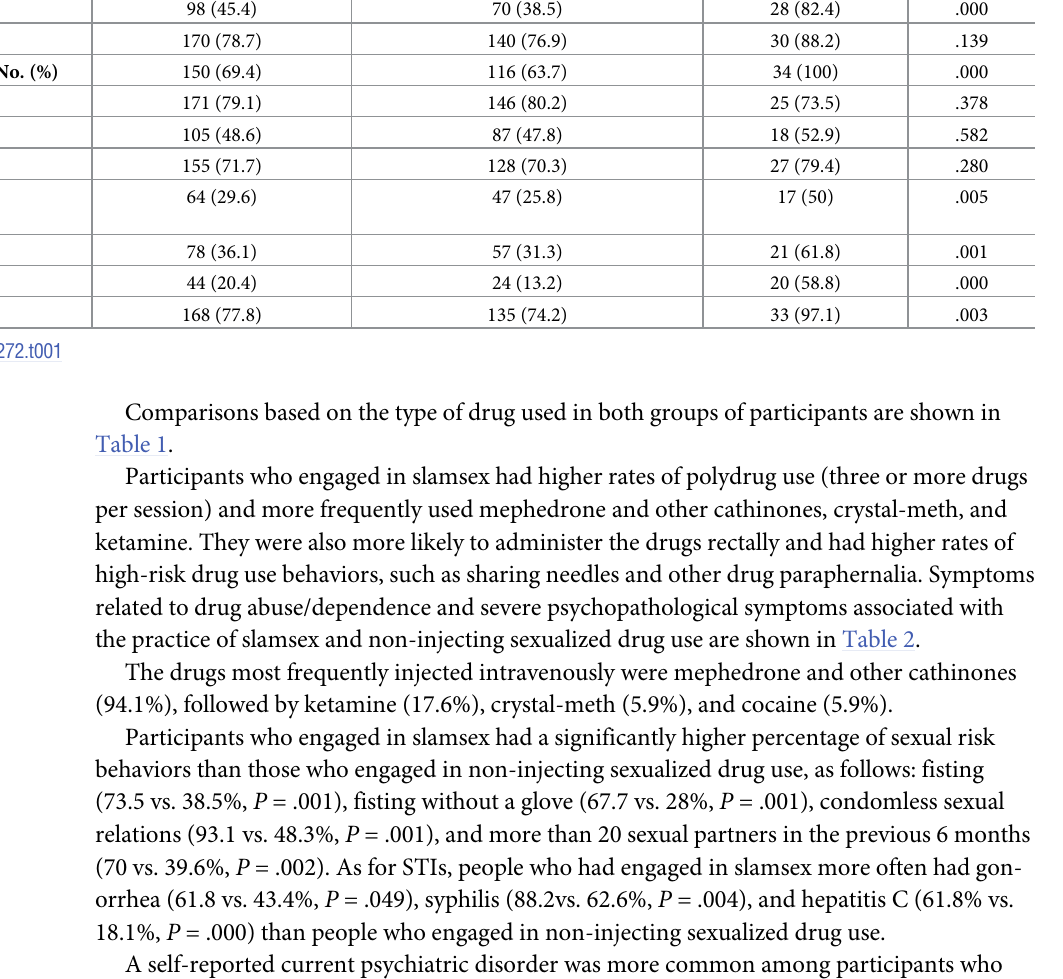
Table 1. Comparisons between participants who engaged in non-injecting sexualized drug use and participants who engaged in slamsex in terms of type of drug used in the previous year. Total sample (N = 216)